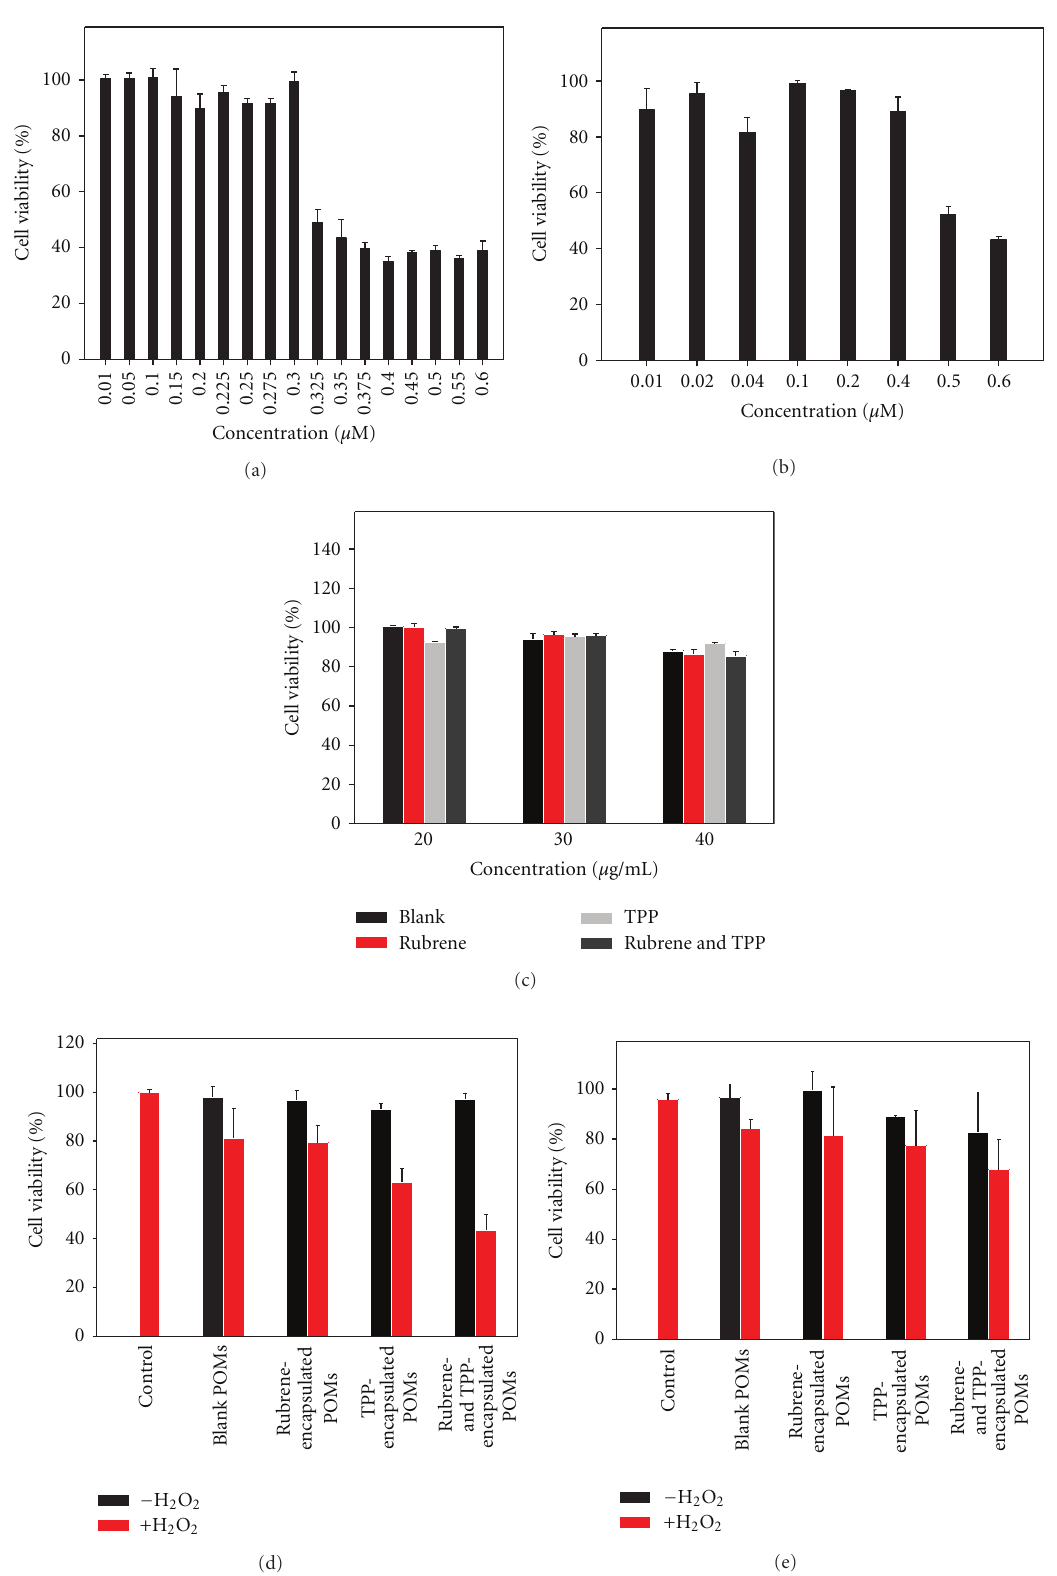
Figure 7: The cytotoxicity of H 2 O 2 to (a) C6 and (b) LoVo cell lines at various concentrations in PBS (pH = 7.4); (c) the cytotoxicity of a diversity of POMs to C6 cell lines without H 2 O 2 . The cytotoxicity of a diversity of POMs to (d) C6 cells and (e) LoVo cells in the presence of 0.2 μ M H 2 O 2 or not, control means only H 2 O 2 treated. All concentrations of POMs were 20 μ g/mL, Rubrene 0.3 μ g/mL, and TPP 2 μ g/mL. Error bars indicate standard deviations from ≥ 3